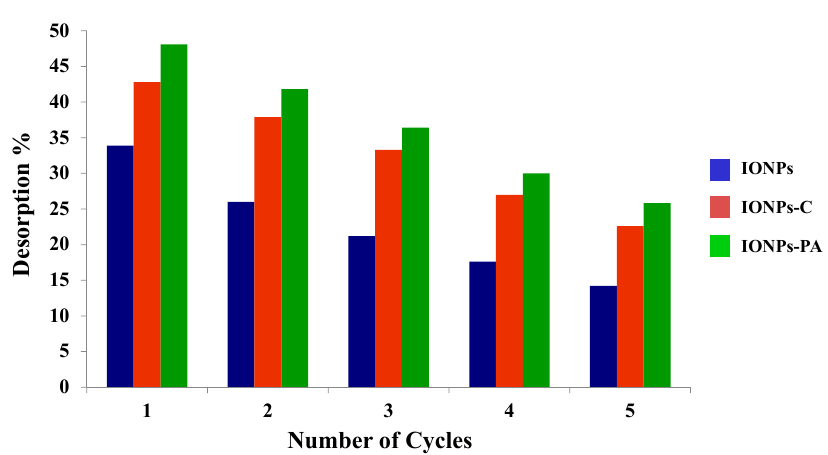
Figure 12. Desorption cycles of adsorbents (IONPs; IONP–C and IONP–PA nanocomposites). Figure 12 . Desorption cycles of adsorbents (IONPs; IONP–C and IONP–PA nanocomposites).